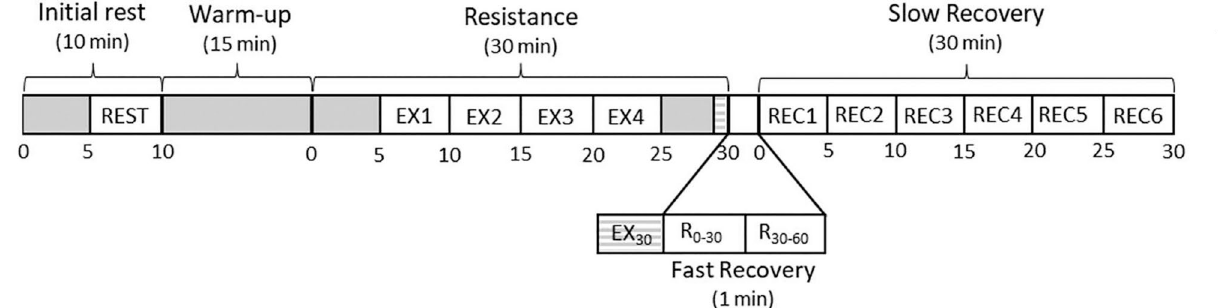
Figure 3 - Heart rate variability analysis